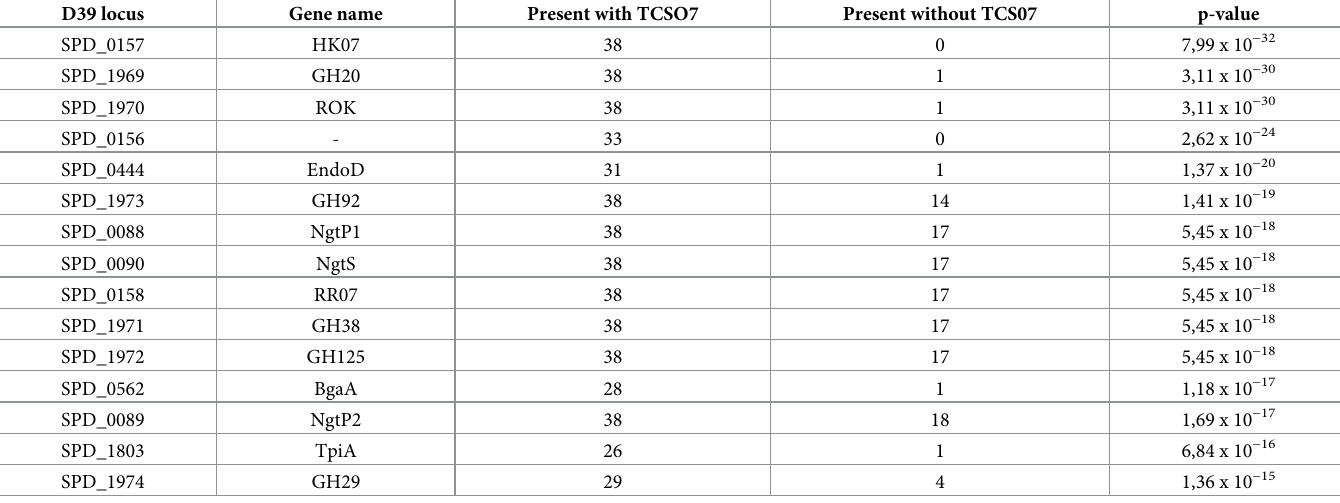
Table 3. Genes of the regulon are co-occur with TCS07. The presence or absence of each gene homolog was evaluated in 38 strains with TCS07 and 80 strains without TCS07. To prevent overrepresentation of strains from species with a high number of available genomes, a maximum of 3 strains were used from each species. The top 15 genes were chosen based on their